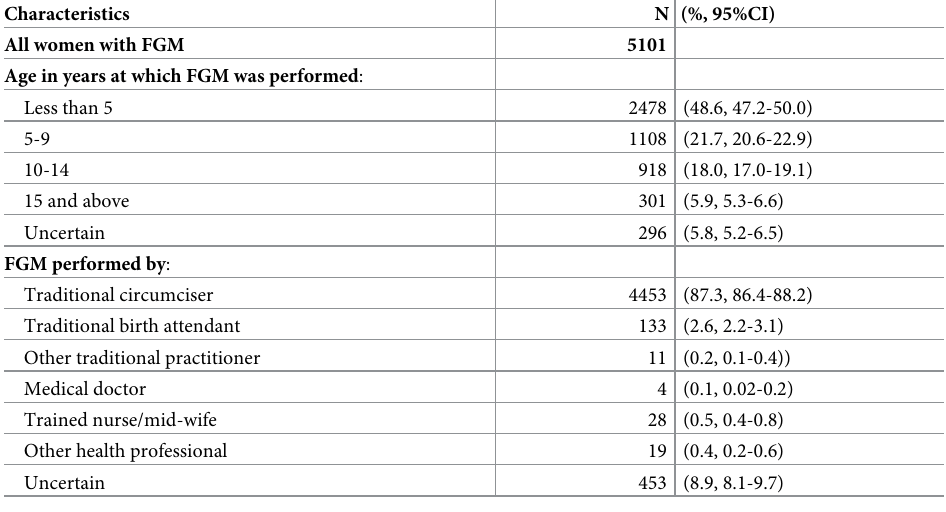
Table 3. Characteristics of women with female genital mutilation (FGM) in Ethiopia in 2016.